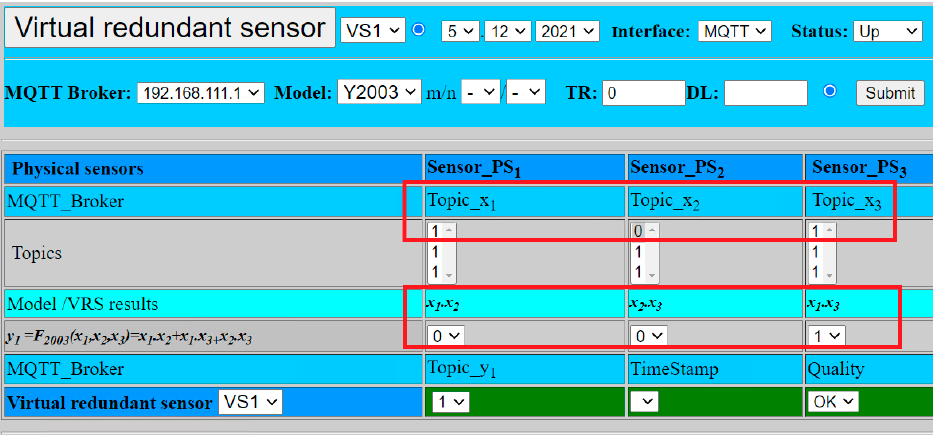
Figure 15. Virtual sensor with fusion function 𝐹 (cid:2870)(cid:2925)(cid:2925)(cid:2871) and negative result.